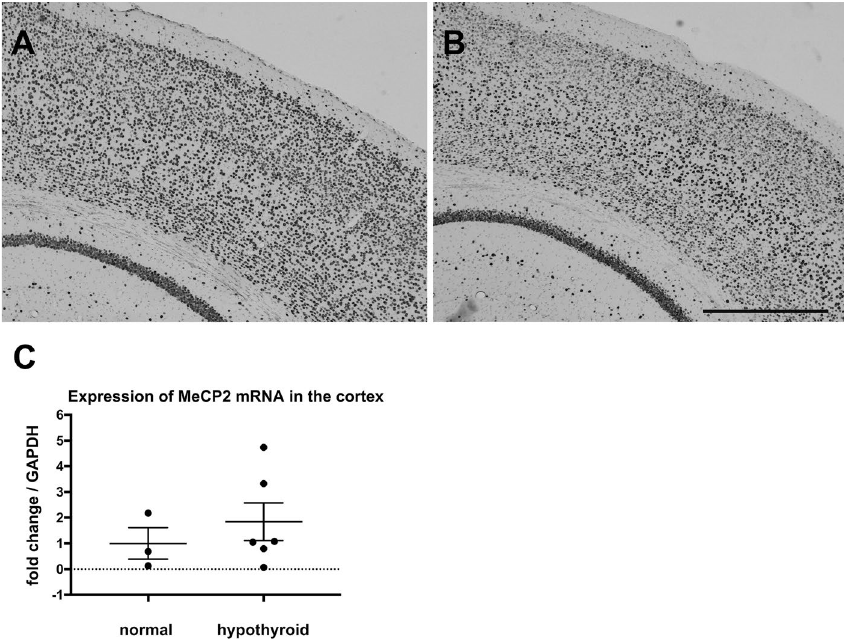
Figure 5. Expression of MeCP2 in the cerebral cortex of mice. ( A , B ) Photomicrographs show immunostaining of MeCP2 in the cerebral cortex of normal ( A ) and hypothyroid mice ( B ) at PD 14, respectively. Scale bar = 500 µm. ( C ) Graph shows the results of qPCR for MeCP2 mRNA in the cerebral cortex of mice at PD 14.